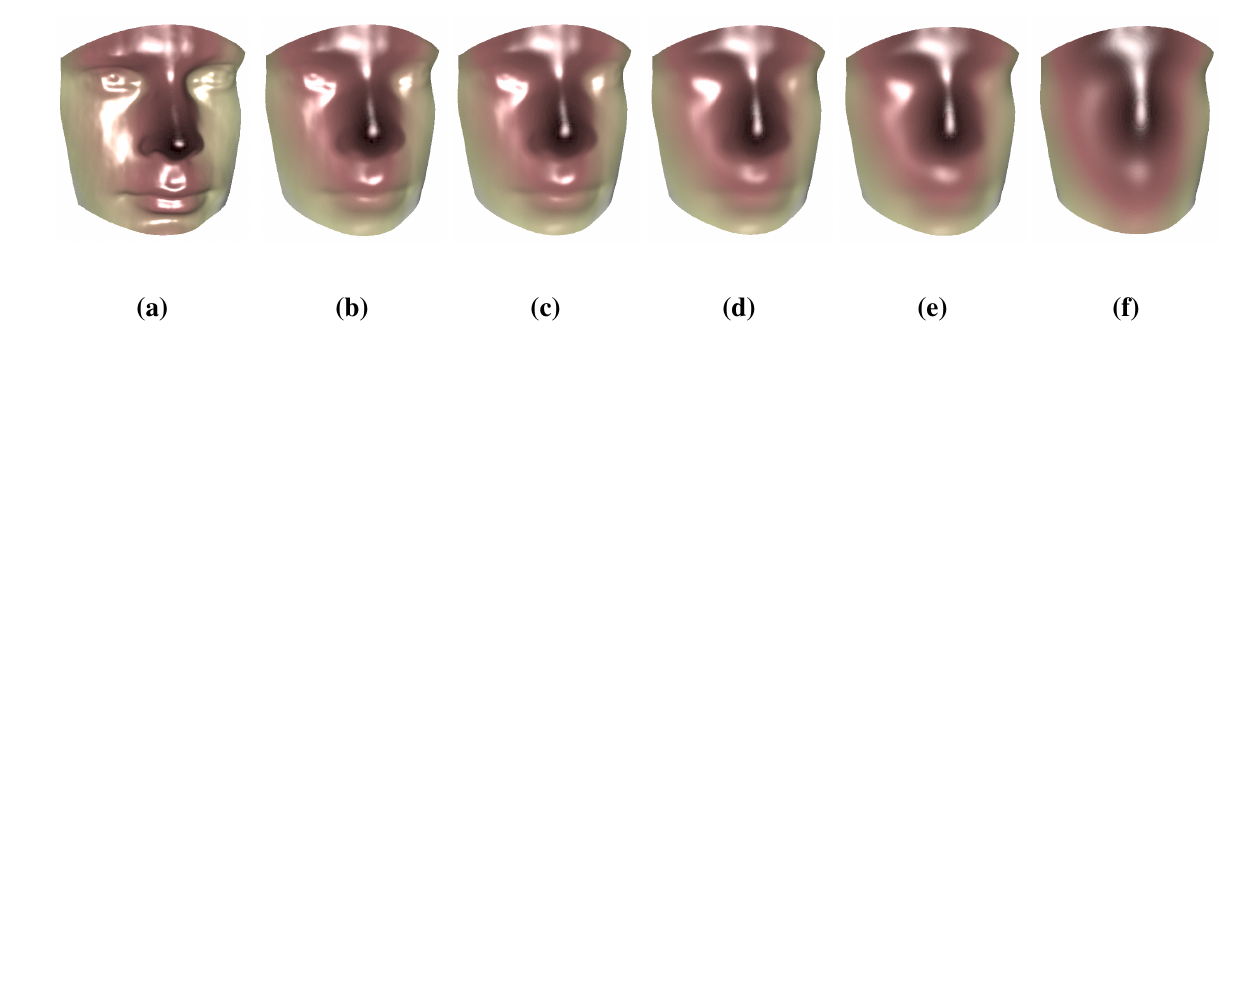
Figure 6. Result of the multi-scale representation of a human face surface. ( a ) The original human face. ( b – f ) The multi-scale representation of the face obtained from the proposed algorithm. The approximation levels of the multi-scale representation decreases from the fine-scale (see ( b )) to the coarse-scale (see ( f )). Note that from (b) to (f), the facial characteristics, such as eyes, nose and mouth, are fading out. This is consistent with our algorithm, which coarsens the ( λ, H ) representation throughout the